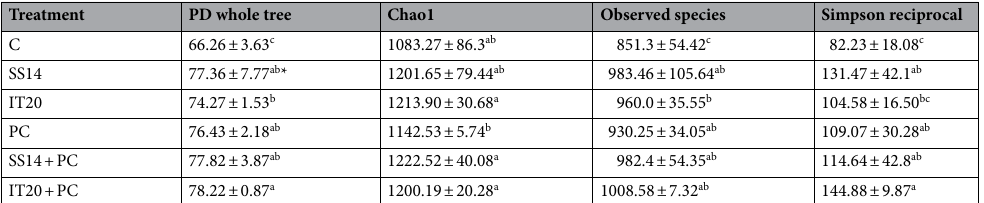
Table 3. Evaluation of alpha diversity in inoculated and non-inoculated samples. Values are the mean counts (averaged from three replicates) ± SE. *Same letters represent non-significant difference according to Duncan’s Multiple Range Test ( P < 0.05